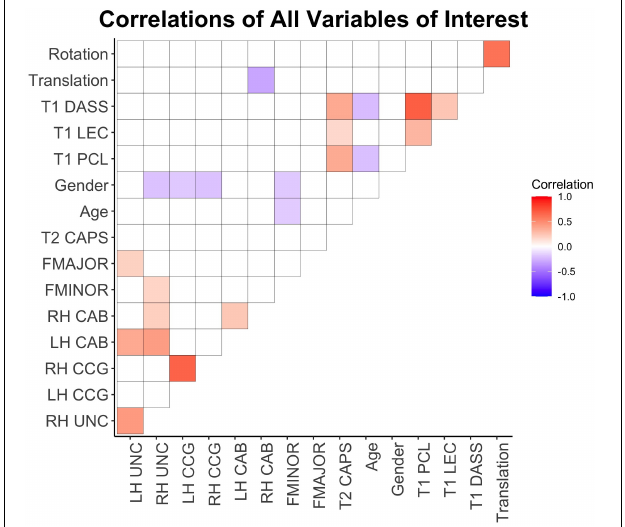
FIGURE 2 | Correlation heatmap of pairwise Pearson correlations between all variables of interest. Warm colors indicate positive correlations and cool colors represent negative correlations. White cells represent non-significant pairwise correlations ( p > 0.05). T1, 2-weeks post-injury; T2, 6-months post-injury; DASS, depression symptom subscale from DASS; LEC, weighted total LEC; PCL, PTSD Checklist; CAPS, Clinician Administered PTSD Scale; FMAJOR, forceps major; FMINOR, forceps minor; CAB, posterior cingulum; CCG, anterior cingulum; UNC, uncinate fasciculus; LH, left hemisphere; RH, right hemisphere.